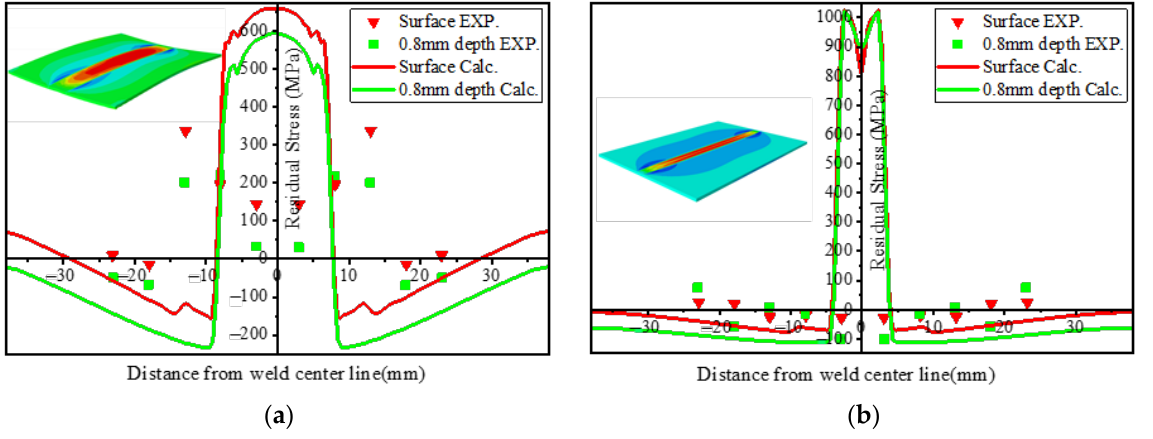
Figure 25. Longitudinal residual stress distribution at different depths: ( a ) TIG weldment, ( b ) LBW weldment.